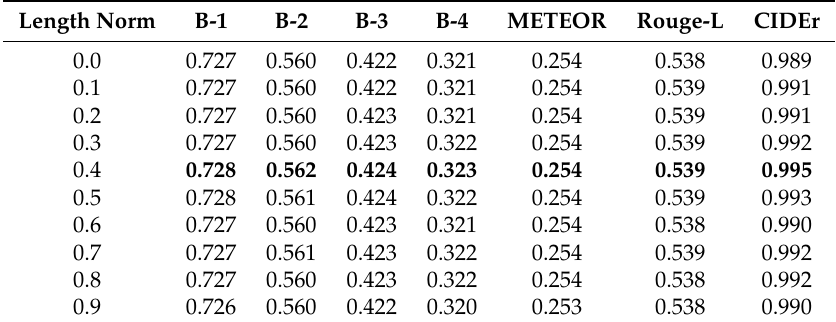
Table 3. Results of our model on different length normalization γ